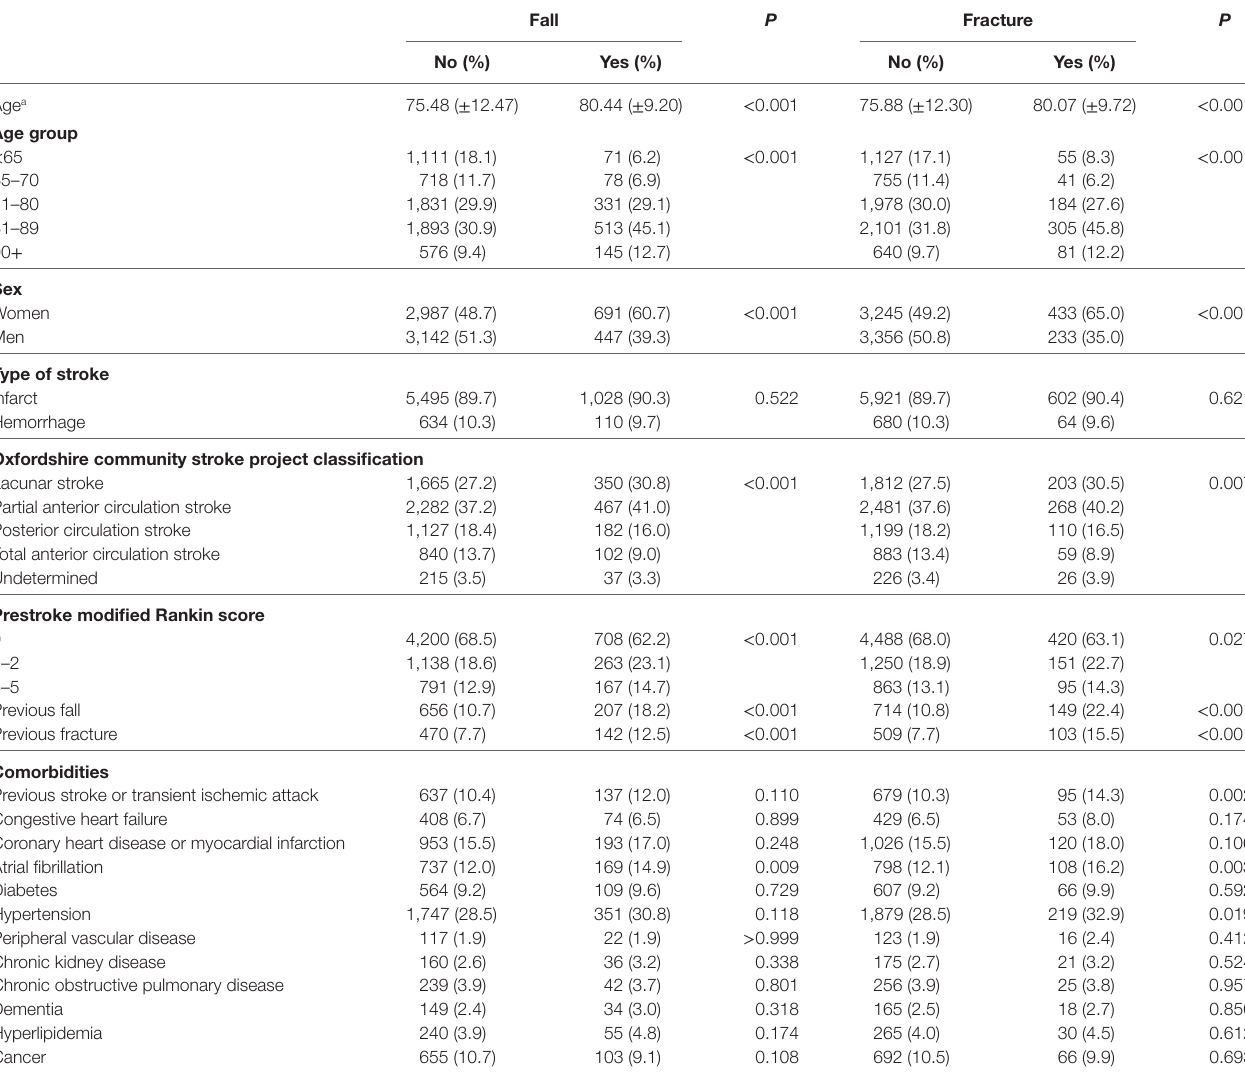
TaBle 1 | Characteristics of patients with and without post-discharge falls and